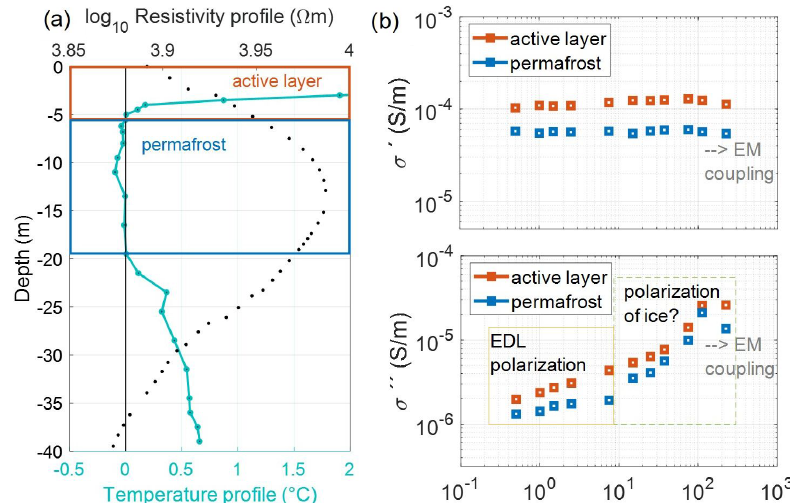
Figure 9. (a) Borehole temperature at BH-1108 at the time of the SIP survey with a resistivity profile at close proximity to the borehole and (b) spectral response for a selected depth column at the borehole extracted from the inverted image of profile H2. Pixel values represent the mean value of real and imaginary components and phase of the complex conductivity extracted for two different layers: 0–5.6m depth (thawed active layer) and 5.6–19.5m depth